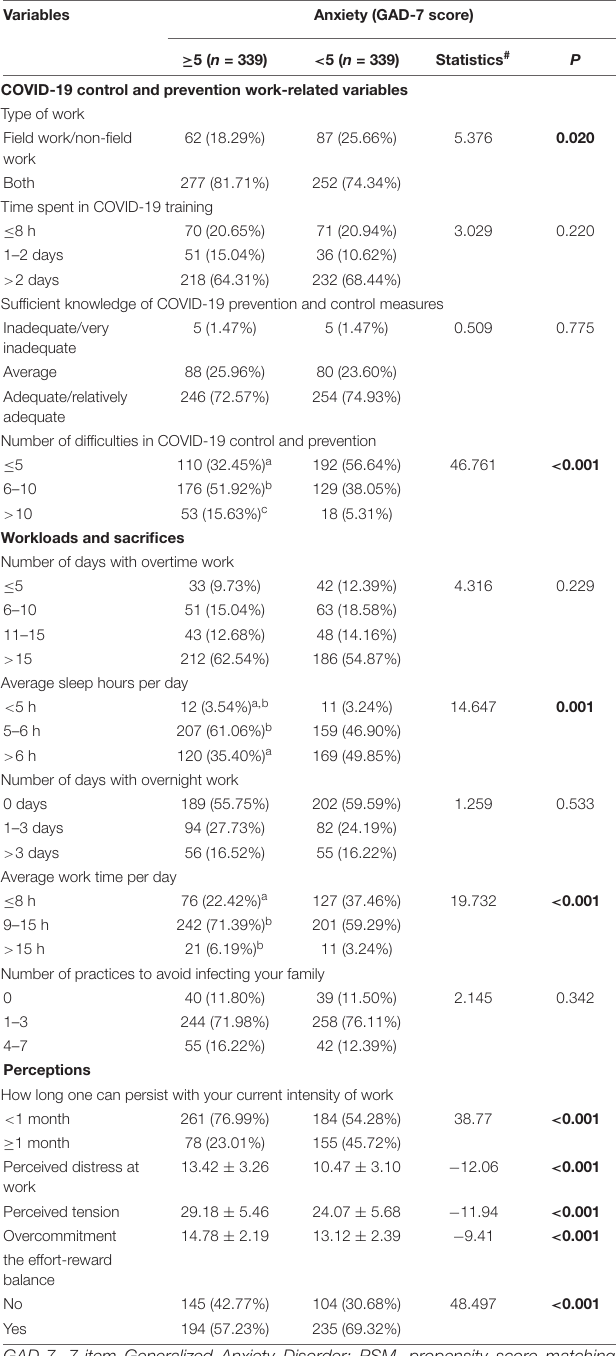
TABLE 3 | Univariate analysis results of variables related to anxiety after PSM ( n ,